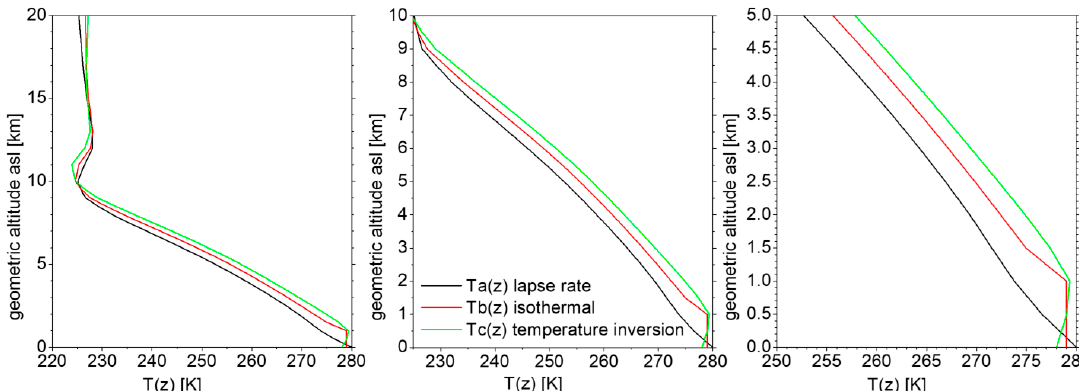
Figure 2. Three representative temperature profiles considered for computing the sensitivity functions: T a (z) for a normal (negative) lapse rate; T b (z) foran isothermal profile in the lower layer; and T c (z) for an temperature profile with an inversion. A zoom has been performed (from the left to the right panel) to exemplify the overall profile up to 20 km, the full tropospheric profile and the profile in the lower troposphere.